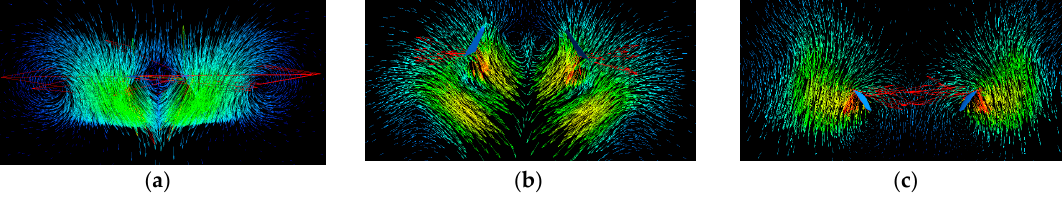
Figure 10. Velocity vector distribution of planar rotors and non-planar rotors: ( a ) traditional planar rotors; ( b ) back-to-back non-planar rotors; ( c ) face-to-face non-planar rotors.